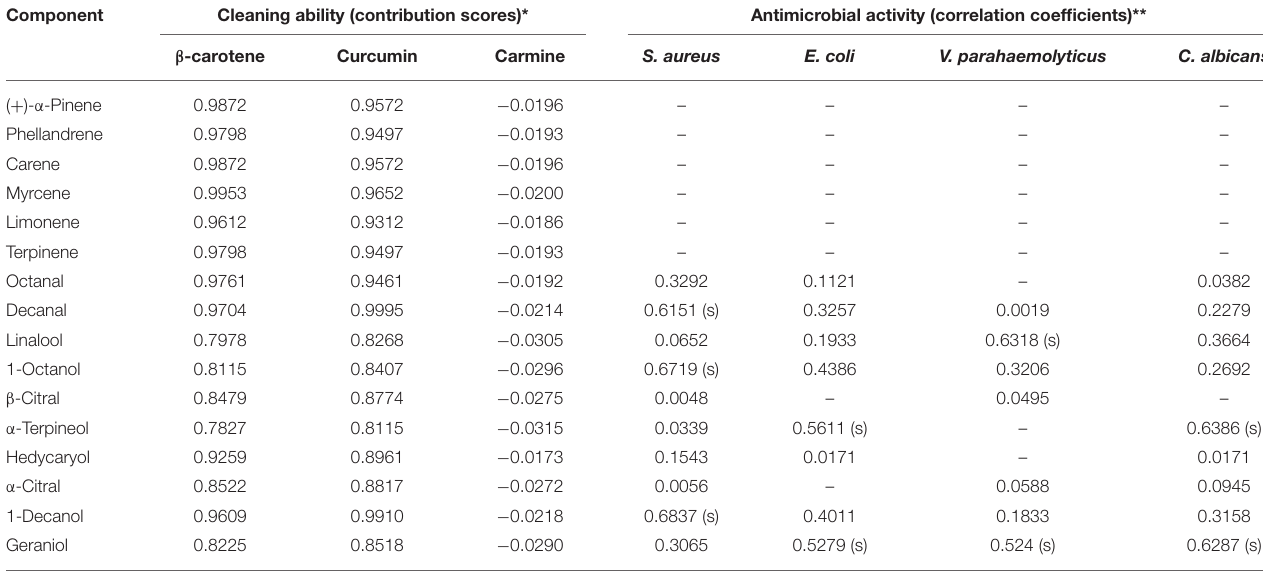
TABLE 2 | Contribution scores for the cleaning ability of pigments and linear correlation coefficients between the antimicrobial activity and citrus oil components.